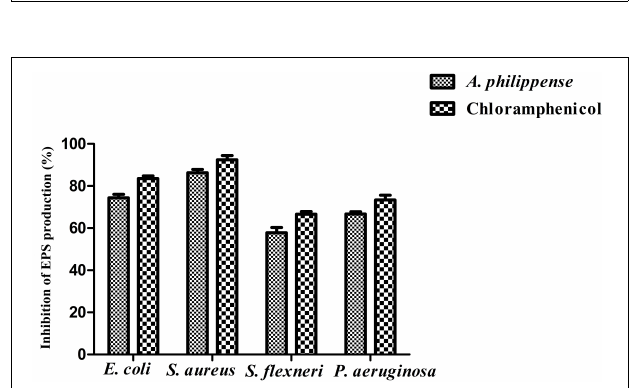
FIGURE 8 | Result of total EPS production inhibition (%) by different bacterial strains in the presence of A. philippense crude extract at their respective MICs. Chloramphenicol was used as positive control. All experiments were carried out in triplicate, and data represent the mean ± SD.